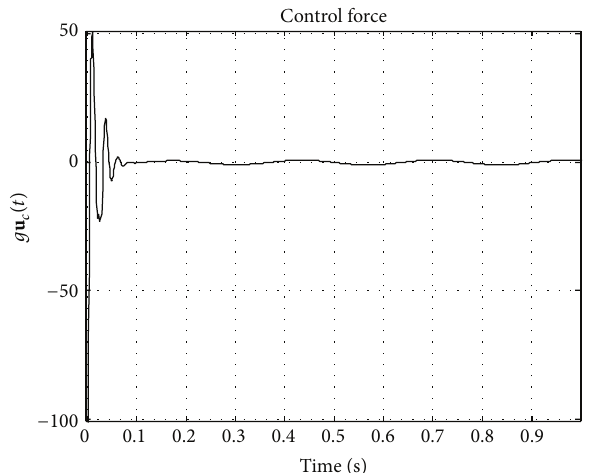
Figure 20: Case 2: control force ( |𝛿| = 0.6 ∘ and 𝑉 = 13.1 m/s). Control surface deflection